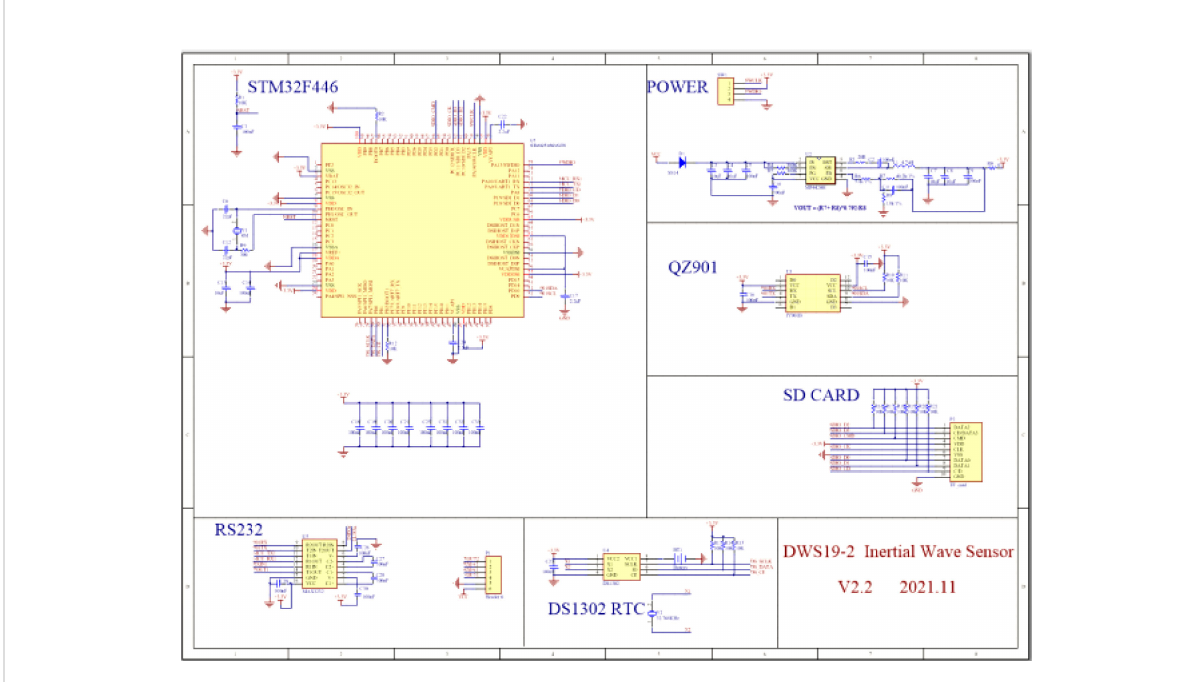
FIGURE 3 Circuit schematic diagram of DWS19-2 wave